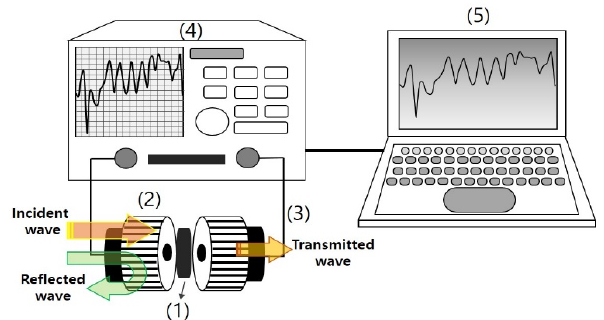
Figure 4. Schematic of the vector network analyzer (VNA) system: (1) sample; (2) wave-guide test holders; (3) coaxial cables; (4) VNA; and (5) computer.